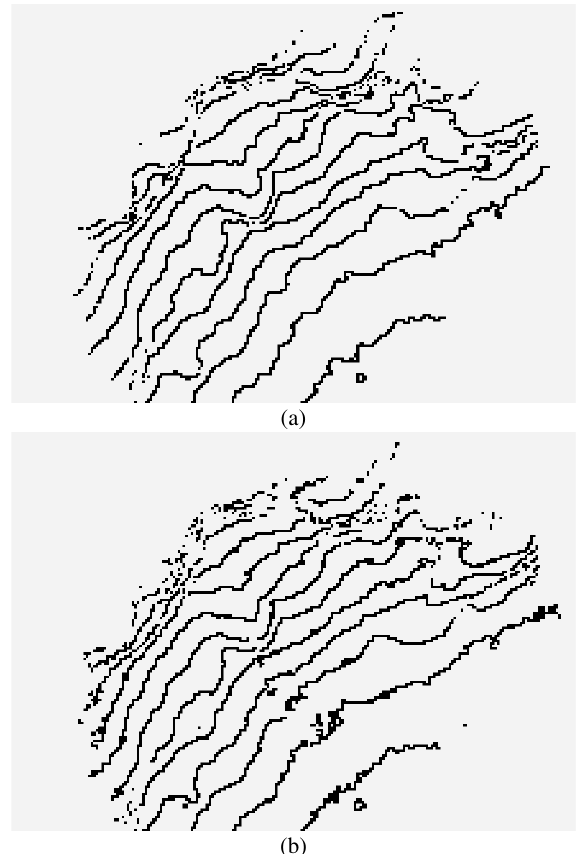
Figure 9. Contour lines (40 cm intervals) in the norther region of the considered study area: (a) photogrammetric survey, (b) ToF